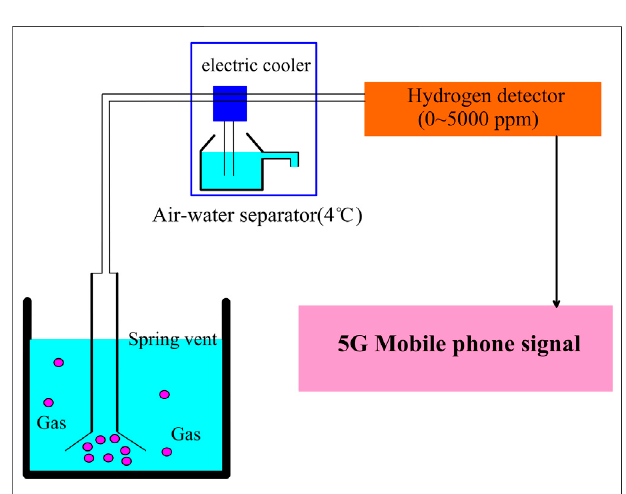
FIGURE 2 | Schematic diagram of H 2 concentration monitoring